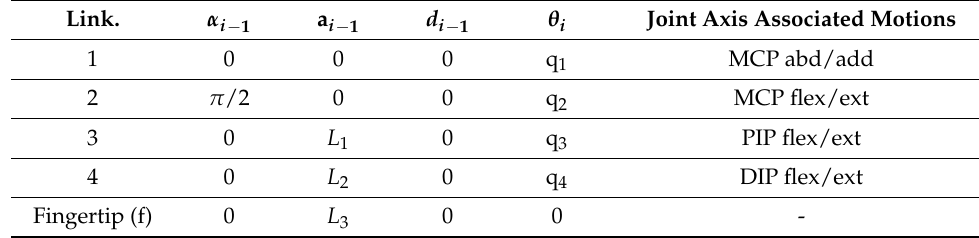
Figure 10. Kinematic chain of finger and exoskeleton. Table 3. Modified DH parameters.